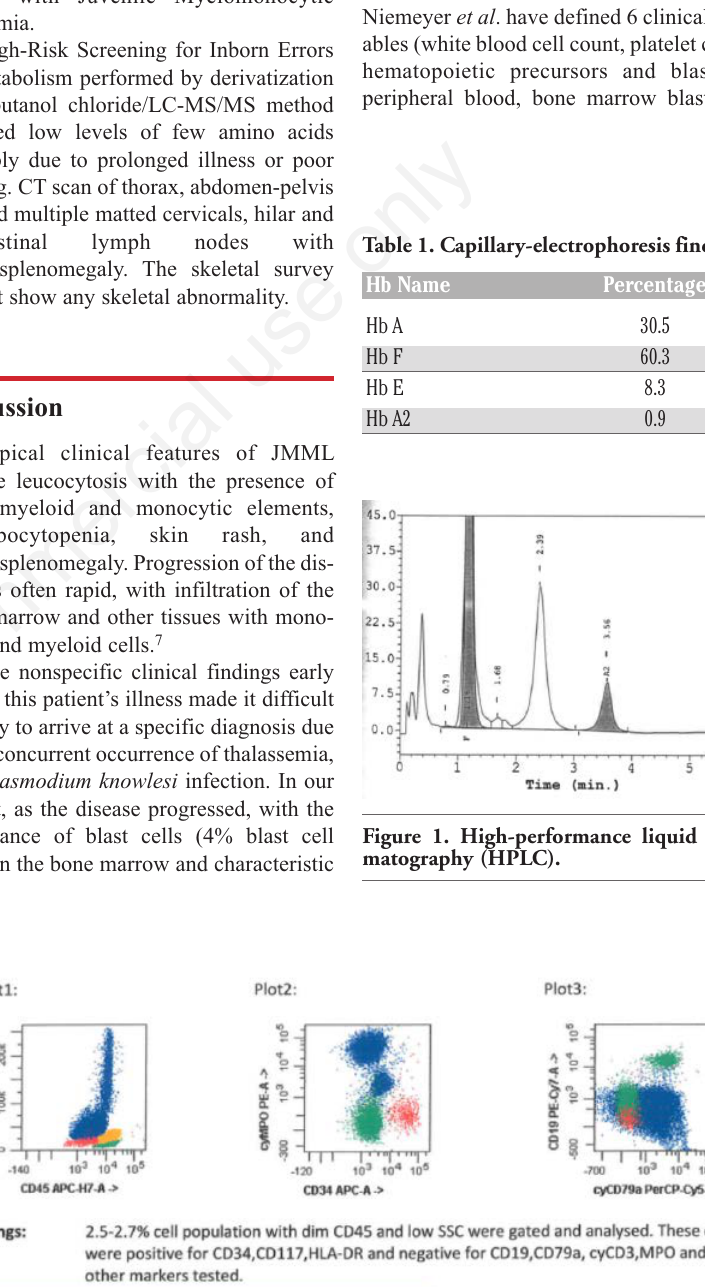
Figure 2. Leukemia-lymphoma immunophenotyping analysis.